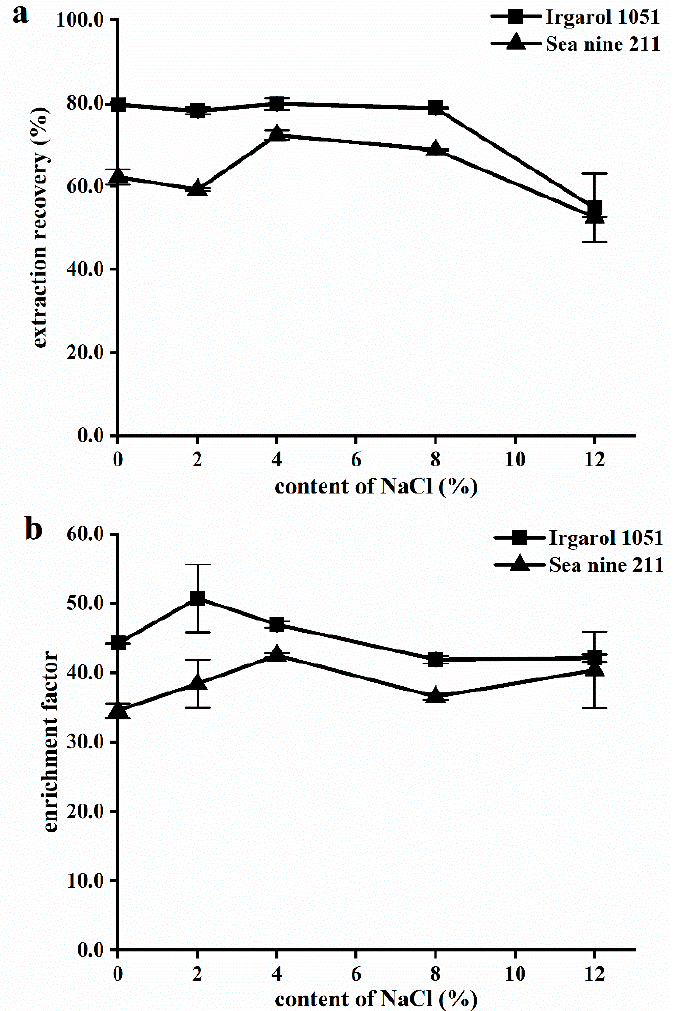
Figure 3. In fl uence of content of NaCl on ( a ) extraction recovery and ( b ) enrichment factor. Extrac- tion conditions: water sample, 5.0 mL; disperser solvent, ethyl acetate 0.4 mL; extraction solvent [HMIm][PF6] 60 mg; pH 6; and cooling temperature 20 °C.